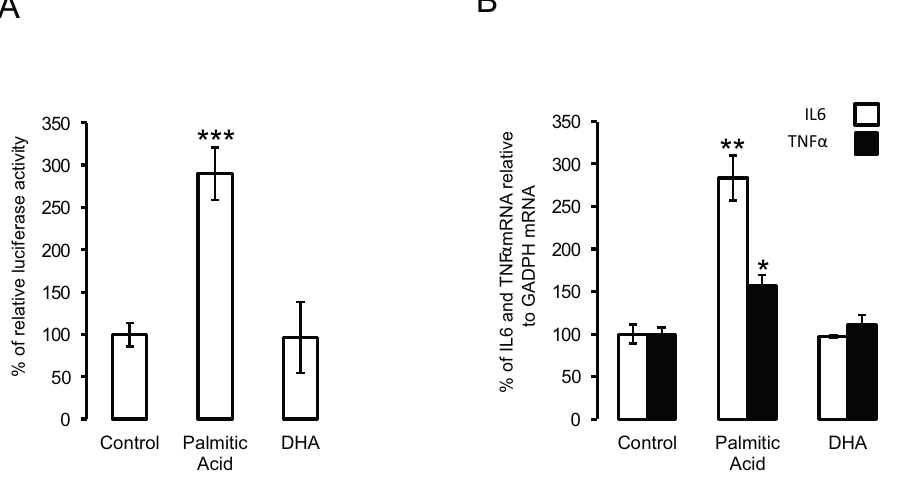
Figure 2. Palmitic acid but not DHA, increased the expression of pro-inflammatory factors. (Panel A ) human SH-SY5Y neuroblastoma cells stably tranfected with NF-κB luciferase reporter gene were treated with palmitic acid, DHA or placebo, and then relative luciferase activity measured. (Panel B ) Human SH-SY5Y neuroblastoma cells were treated with palmitic acid, DHA or placebo and then IL6 and TNFα expression was determined using adequate primers, and normalized using GAPDH. Data were presented as means ± SEM (n = 3), * and ** denoted significant differences vs control at p < 0.05 and p < 0.005,